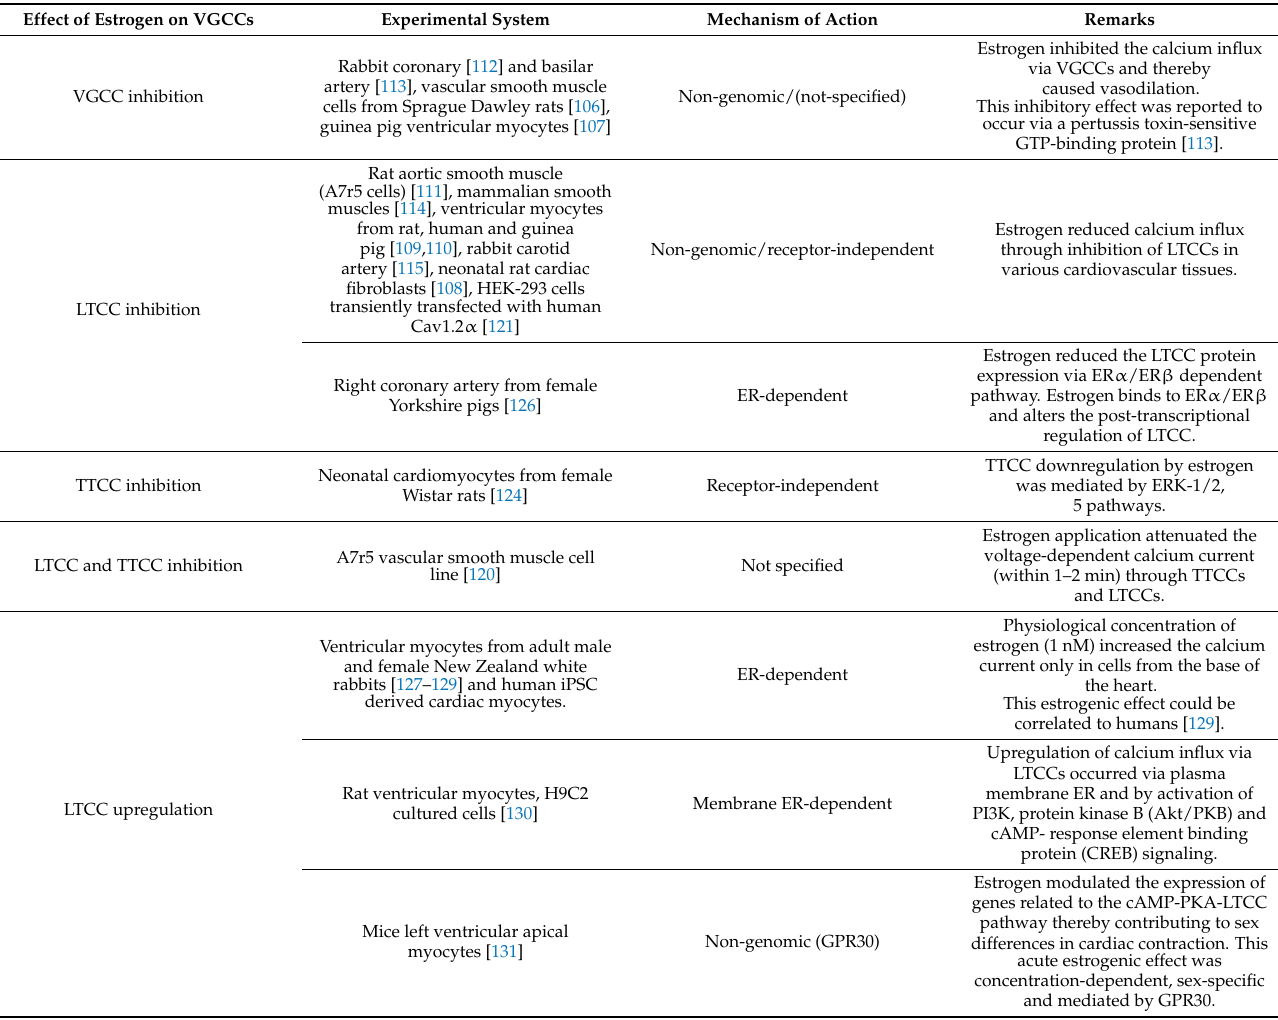
Table 2. Estrogenic modulation of VGCCs in cardiovascular tissues in physiological